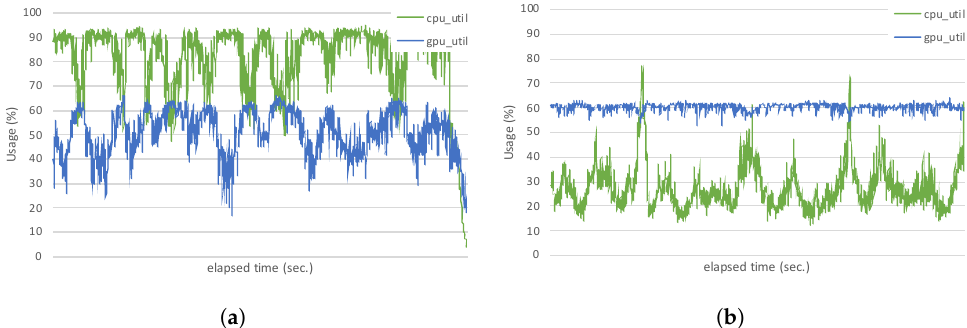
Figure 5. Comparison of CPU and GPU usages (%) of ASR systems using the baseline acoustic score computation method for ( a ) LSTM-based AM and ( b ) BLSTM AM with the test set. The green and blue lines indicate the CPU and GPU usages.